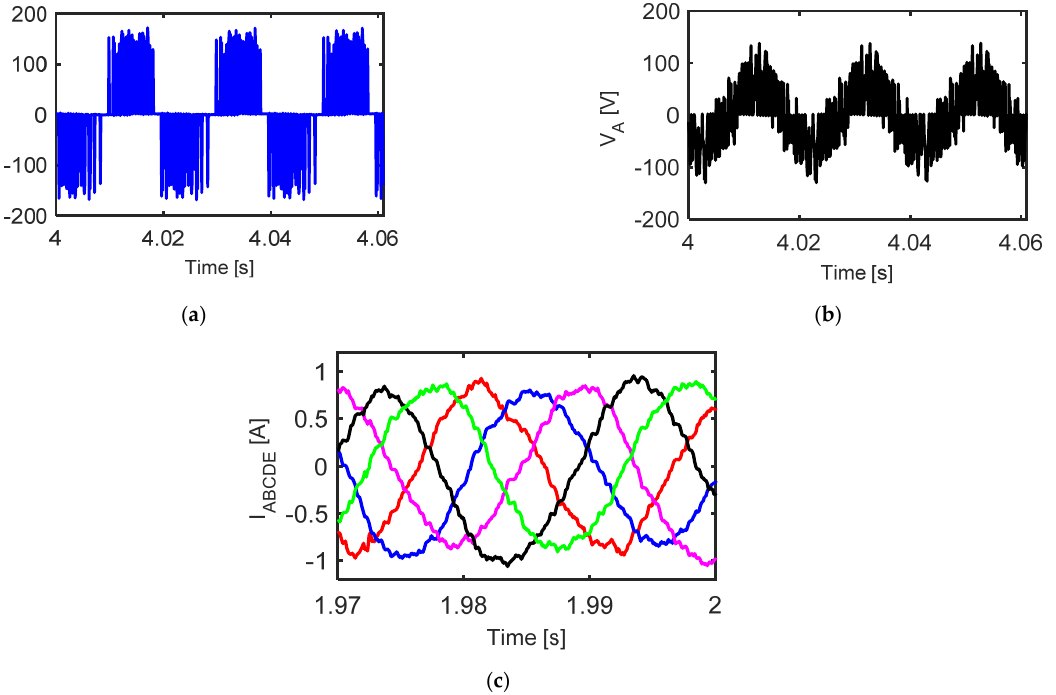
Figure 14. Experimental results at 50 Hz output frequency ( a ) output line voltage, ( b ) output phase voltage and ( c ) output phase currents.